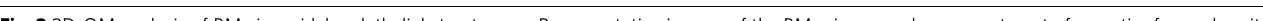
Fig. 3 3D-QM analysis of BM sinusoidal endothelial structures. a Representative images of the BM microvascular compartment of an entire femoral cavity (left; scale bar 1 mm), including arterial (light blue) and sinusoidal vessels (red). Zoomed-in images (right) reveal distinct features of BM sinusoids and arteries in diaphysis (top) and metaphysis of femurs (bottom). Scale bars, 300 µ m. b 3D reconstruction of a confocal image stack acquired in a large region of a femoral diaphysis immunostained for the sinusoidal endothelial markers CD105 (white) and Endomucin (Emcn, red). Scale bar, 100 µ m. Transitional zone (type H) vessels present mostly at the junction of arterioles and sinusoids in the endosteal regions are strongly positive for Endomucin and weakly express CD105 (marked by arrowheads). c Endomucin signal (white) was used as input for our customized algorithm to reconstruct sinusoids in diaphysis (DIA) and metaphysis (MET) of femoral BM cavities. Scale bar 200 µ m. See also Supplementary Fig. 4. d Fraction of entire BM space occupied by intrasinusoidal volumes in femoral diaphysis and metaphysis ( n = 11). Bars show the mean and dots represent data from single femurs from different mice. e Left panel depicts a representative high-resolution image of a 2D optical section in which the nuclei of SECs are visible and can be manually annotated. Scale bar, 30 µ m. Three zoomed-in pictures with examples of detected SEC nuclei (marked by arrows) are shown. Scale bars, 10 µ m. The resulting 3D reconstruction of SEC nuclei (yellow) on the segmented sinusoids (red) is shown on the right panel. Scale bar, 30 µ m. f Quanti fi cation of SEC nuclei per mm 3 of BM tissue volume. Individual dots correspond to values obtained from one single femur by calculating the weighted average of two images from different BM regions ( n = 12) and bars depict mean values. g Gating strategy for identi fi cation of BMECs and distinction and quanti fi cation of AECs and SECs by FC. h Comparison of total SECs per femur as determined by 3D-QM and FC. Lines connect dots corresponding to values determined for contralateral femurs of the same individual mice ( n = 11). Signi fi cance was analysed using Mann – Whitney test. *** P < 0.0001; n.s. not signi fi cant with P <